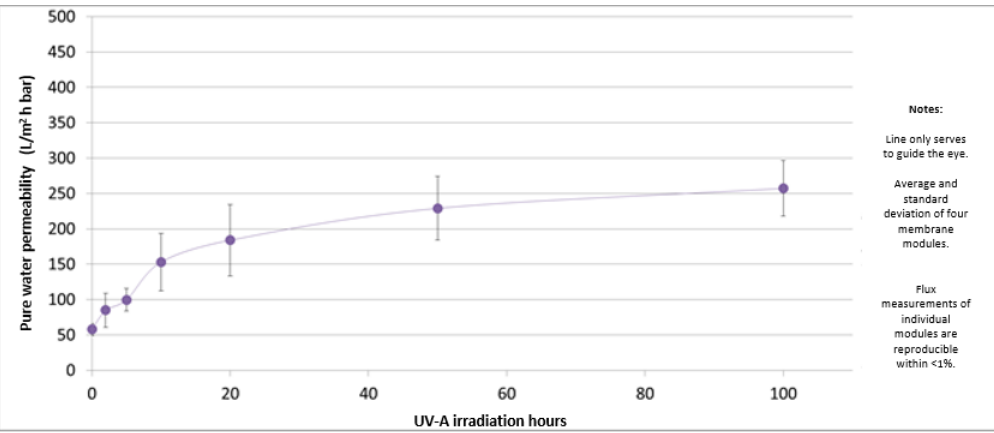
2 hollow fibers.